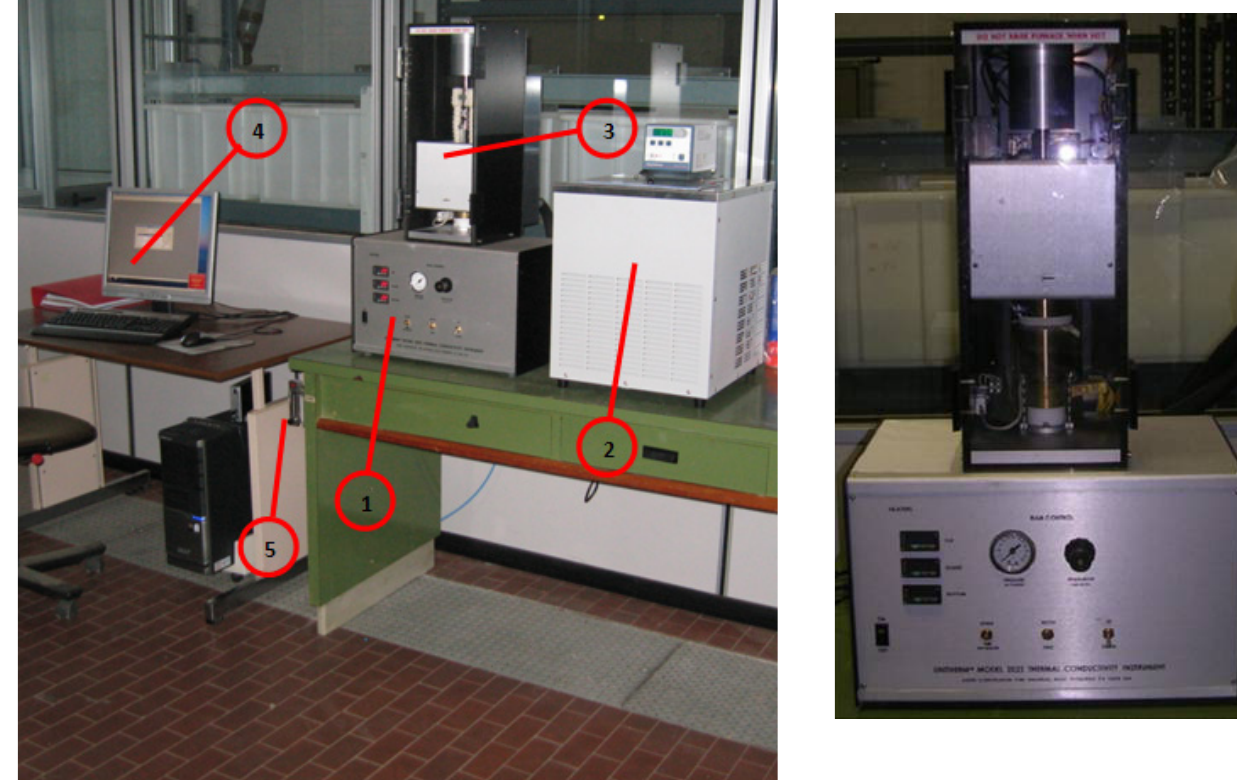
Fig. 1. (Color online) HFT laboratory at CertiMaC – ENEA, in Faenza. (1) Command and Control Panel in order to supervise the temperatures along the stack and the cylinder pressure. (2) Chiller with temperature automatic controller. (3) Stack section with HFT and Guard Heater. (4) Personal Computer with software and acquisition system. (5) Control and Command Panel for air and nitrogen system.